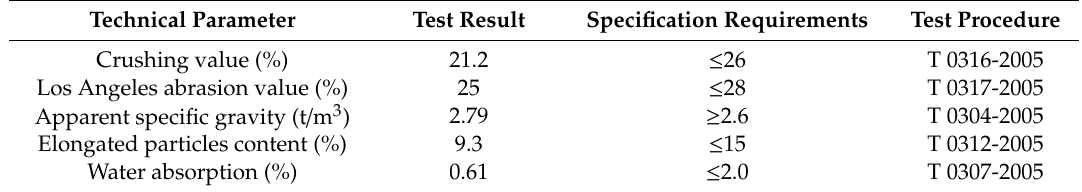
Table 2. Technical parameters of coarse aggregate.